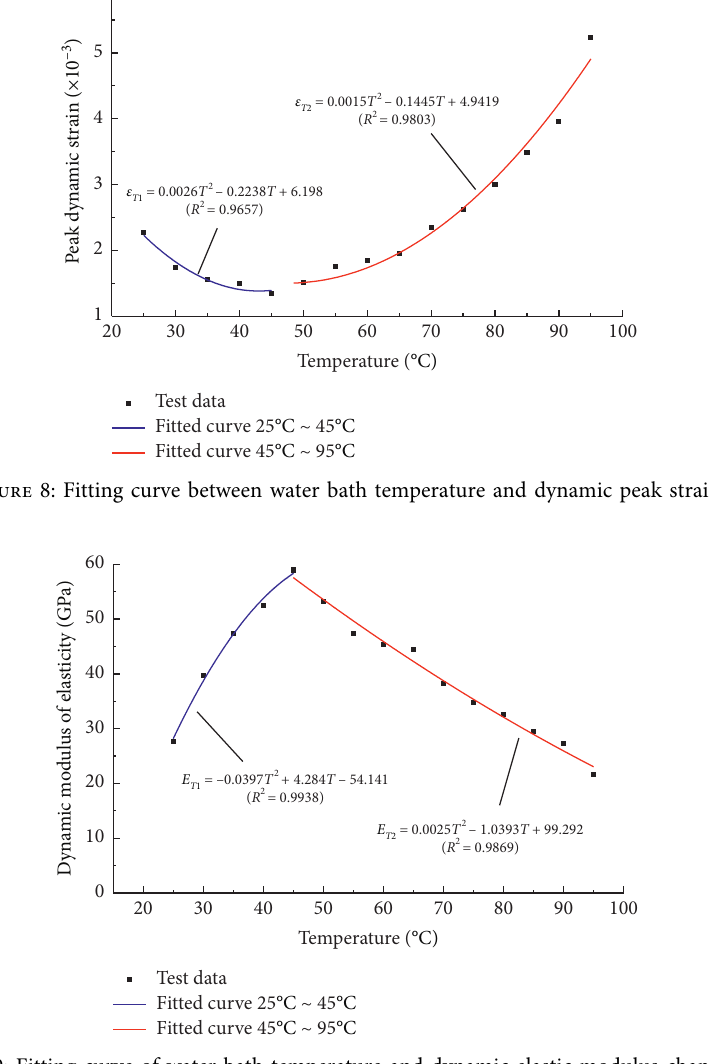
Figure 9: Fitting curve of water bath temperature and dynamic elastic modulus change law.